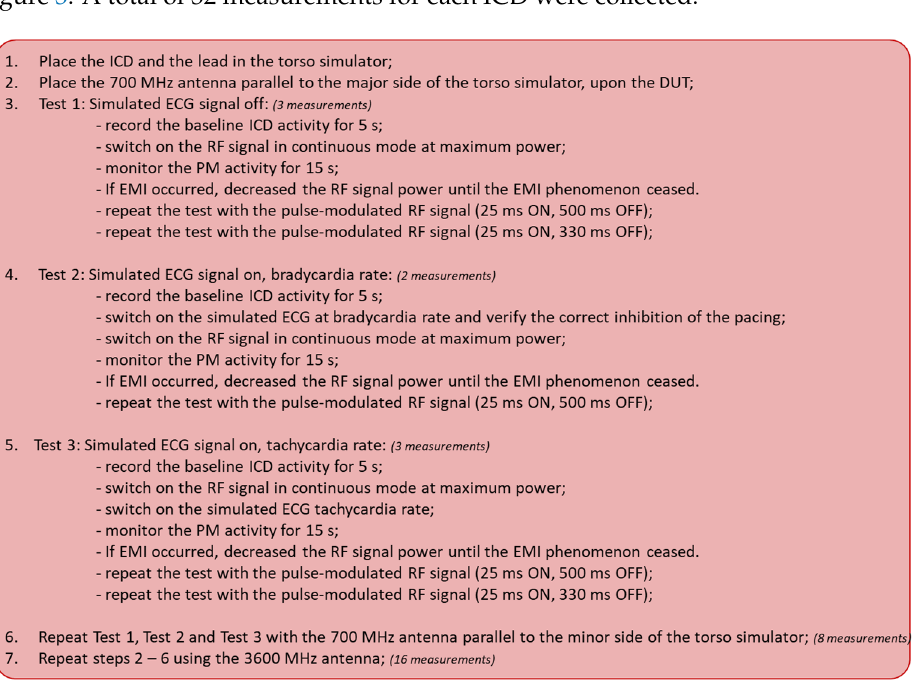
Figure 3. The flow chart of the test procedure followed for ICDs measurements. A total of 32 measurements for each ICD were